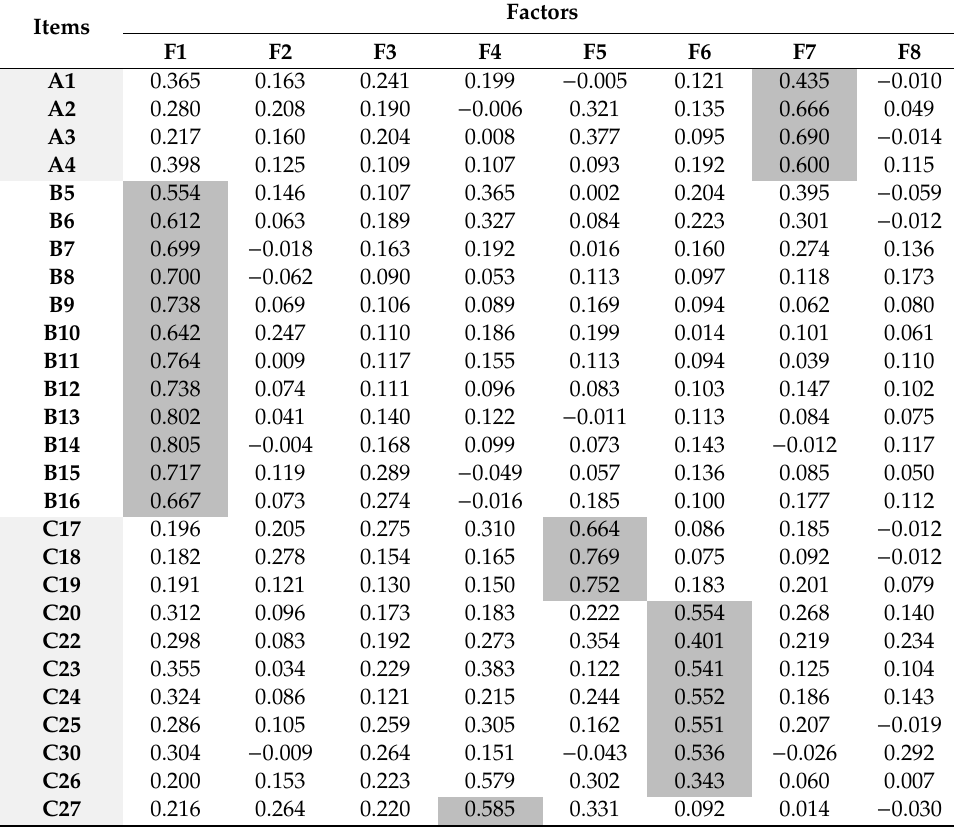
Table 3. Factor analysis of medical professional competence